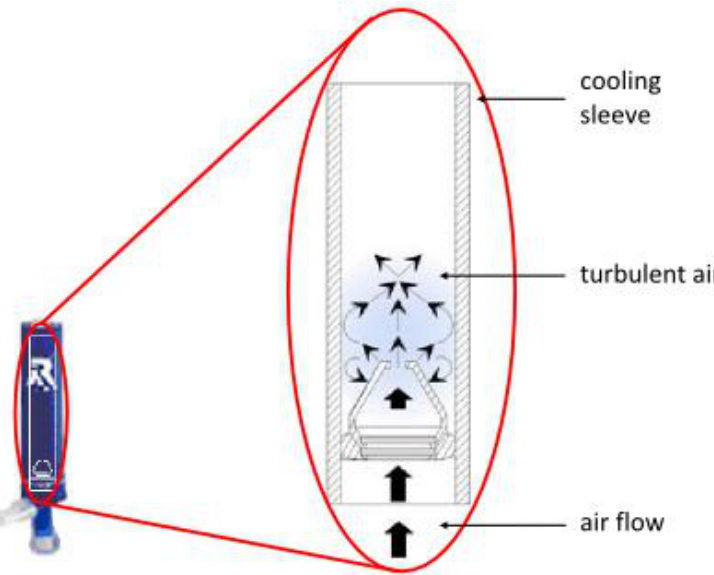
Figure 8. Illustration and diagram of the Rtube device for collecting